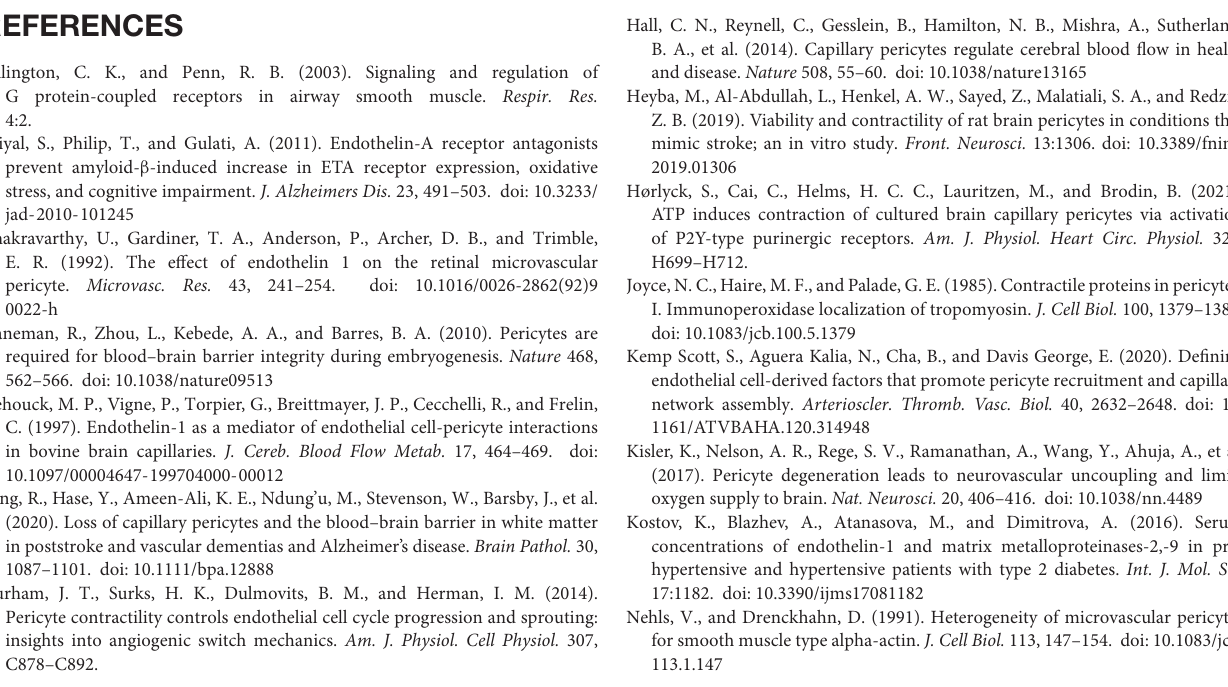
Supplementary Figure 1 | (A) Graphical representation of cell contraction on impedance plates. Contraction reduces the cell surface area in contact with culture dish electrodes represented by a reduction in cell index. (B) Example impedance trace readout from the xCELLigence software. Image (B) taken and adapted from ACEA Biosciences Inc. Supplementary Figure 2 | Fetal human brain-derived vascular pericytes (fHBVPs) were seeded in a 96-well plate at 5,000 cells per well and left to settle overnight. Pericytes were incubated with purified recombinant EDN1 (diluted in serum free medium) for 72 h ( n = 1). A BRDU incorporation assay (Abcam, United Kingdom) was used according to the manufacturer’s instructions to assess pericyte proliferation. Supplementary Figure 3 | (A) Fetal human brain-derived vascular pericytes (fHBVPs) and (B) adult human brain derived-vascular pericytes (aHBVP) were seeded in black clear bottomed 96-well plates at 5,000 cells per well and left to settle overnight. Pericytes were then incubated with recombinant A β peptides (rPeptide, diluted in 35% acetonitrile as a stock and diluted in serum-free medium) for 24 h. Cell toxicity was assessed using an ethidium dye, in the live/dead mammalian cell assay (Invitrogen, United Kingdom), according to the manufacturer’s guidelines ( n = 2). The percentage of cells that had died was calculated with reference to the untreated control wells. The bars represent the mean values and